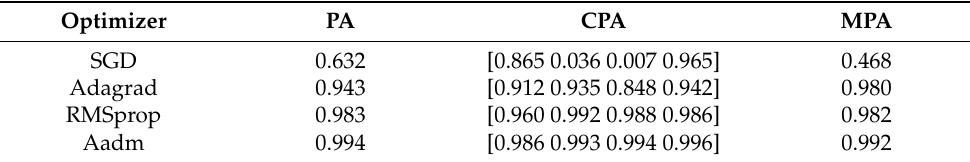
Table 3. The experimental results under different optimizer.